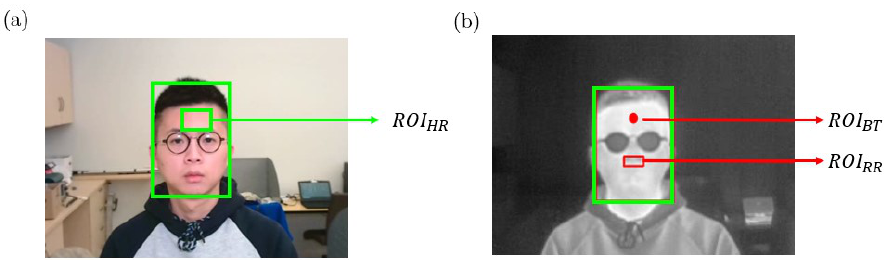
Figure 5. ROIs employed for vital signs estimation, ( a ). the location of ROI HR on the RGB image, ( b ). The locations of ROI RR and ROI BT on the simultaneous thermal image.